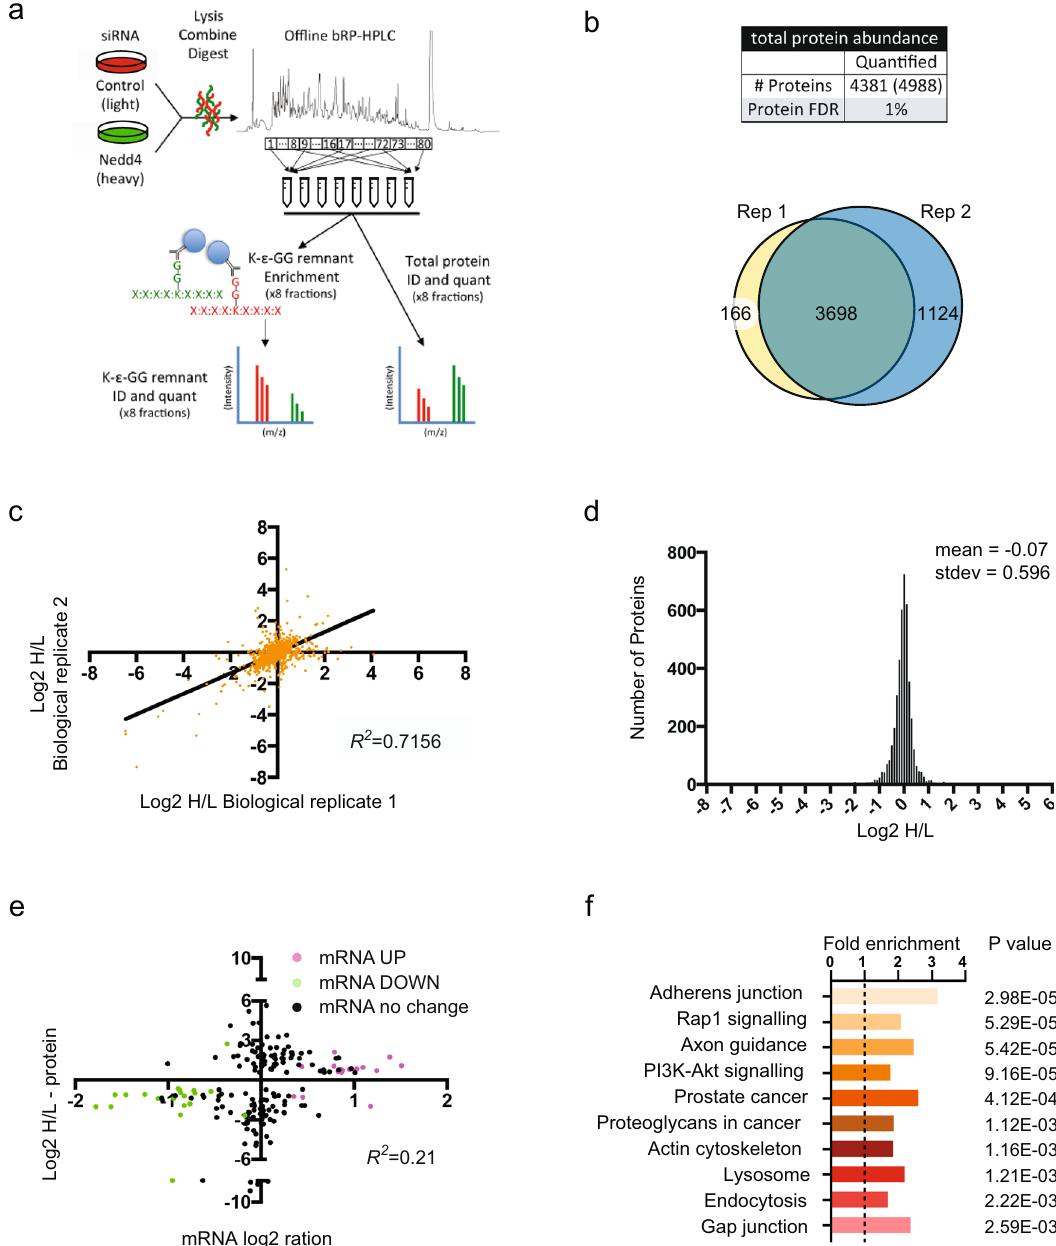
Fig. 1 Quantitative proteomic pro fi ling for NEDD4 regulated proteins and molecular pathways. a Work fl ow for analysis of ubiquitin remnant enriched and pre-enrichment peptides. SILAC labelled NCU10K cells treated with low GC (control, light - red) or Nedd4 (heavy, green) siRNA were lysed in 8 M urea, equal amounts (5 mg each) were combined and digested with trypsin. The resulting peptides were fractionated by of fl ine basic reversed-phase HPLC into 80 fractions that were then pooled in a discontinuous pooling strategy into 8 fractions. The bulk of each fraction was then subjected to ubiquitin remnant (K- ε -GG remnant) enrichment and enriched peptides identi fi ed and quanti fi ed by LC-MS/MS. A small amount of each fraction was also analysed prior to enrichment for total protein identi fi cation and quanti fi cation for use in subsequent normalisation and data analysis. b The combined number of quanti fi ed protein groups (total number observed in brackets) and Venn diagram showing overlap of protein group IDs from the total protein (unenriched) fractions across 2 biological replicates (rep). c Correlation of log2 H/L ratios for each protein group common to both replicates ( R 2 = 0.7156). d Frequency distribution of log2 H/L ratios for protein groups with a mean of − 0.07 and standard deviation of 0.596. e Correlation of total protein abundance (Y-axis) to gene expression data (X-axis) ( R 2 = 0.21) for proteins with altered abundance. Proteins indicated in green had a statistically signi fi cant reduction in gene expression (step-up p < 0.05). Proteins indicated in magenta had a statistically signi fi cant increase in gene expression (step-up p < 0.05) as determined by two-sided ANOVA with adjustments made using Benjamini-Hochberg Step-Up controlling procedure. f Top 10 annotations from process network analysis of differentially expressed genes at the mRNA level using DAVID. Fold enrichment and p -values derived using Fisher ’ s exact test with adjustments using Bonferroni, Benjamini and FDR methods are